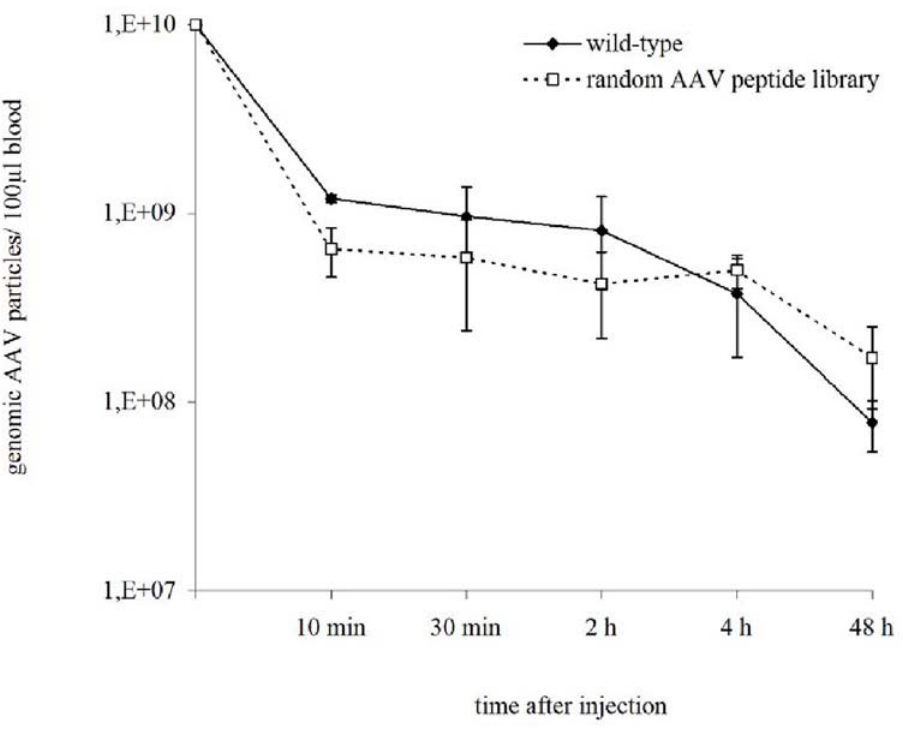
Figure 3. Kinetics of circulating AAV peptide library particles is similar to wild-type AAV. A random X 7 peptide library or wild-type AAV-2 viruses were injected intravenously at 1 6 10 10 vg per mouse. Blood samples were collected after indicated time points and the amount of circulating viral particles in the serum was determined by real-time PCR. Data represent mean values from n=3 mice per group, analyzed in triplicates 6 SD.